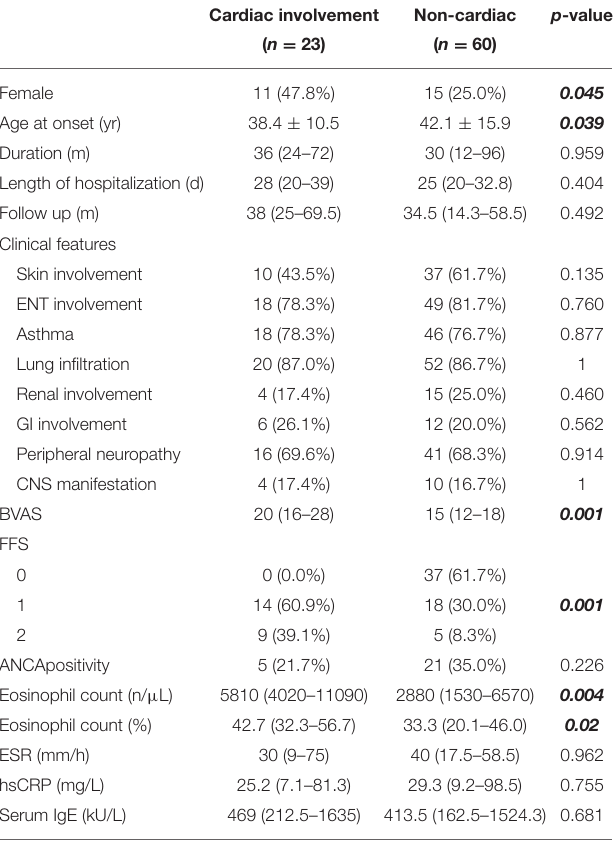
TABLE 1 | Characteristics of EGPA patients with or without cardiac